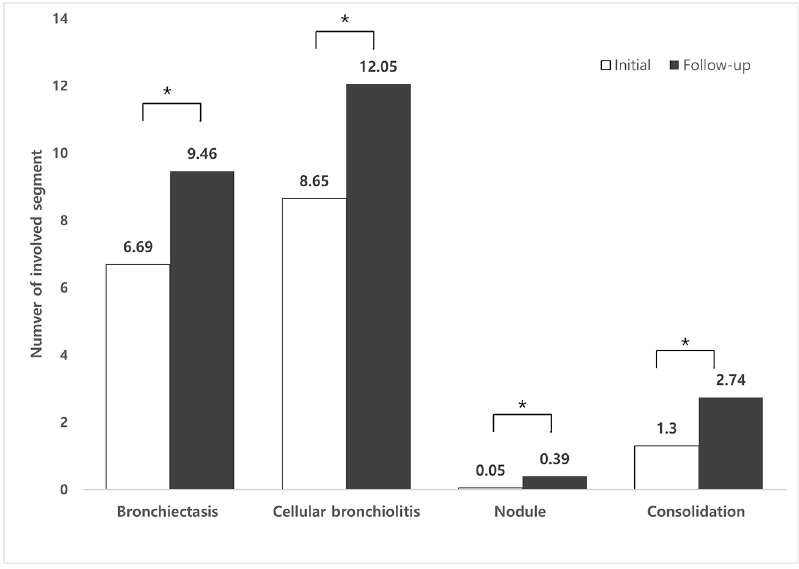
Fig 4. The change of number of involved segment in each radiologic findings. Asterisks indicate statistically significantdifferences (p < 0.001).